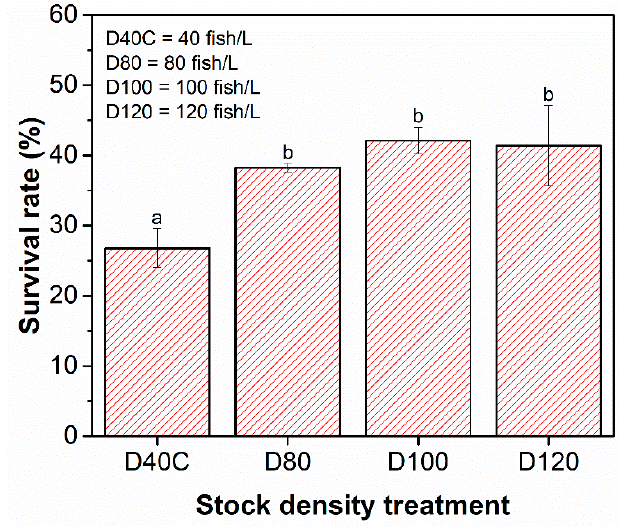
Figure 5. The survival rate of striped catfish ( Pangasianodon hypophthalmus ) larvae at various stock density treatment levels in exogenous stage, at mean temperature of 27 °C. Vertical bars indicate standard error. Different letters denote significant differences between groups ( p < 0.05).